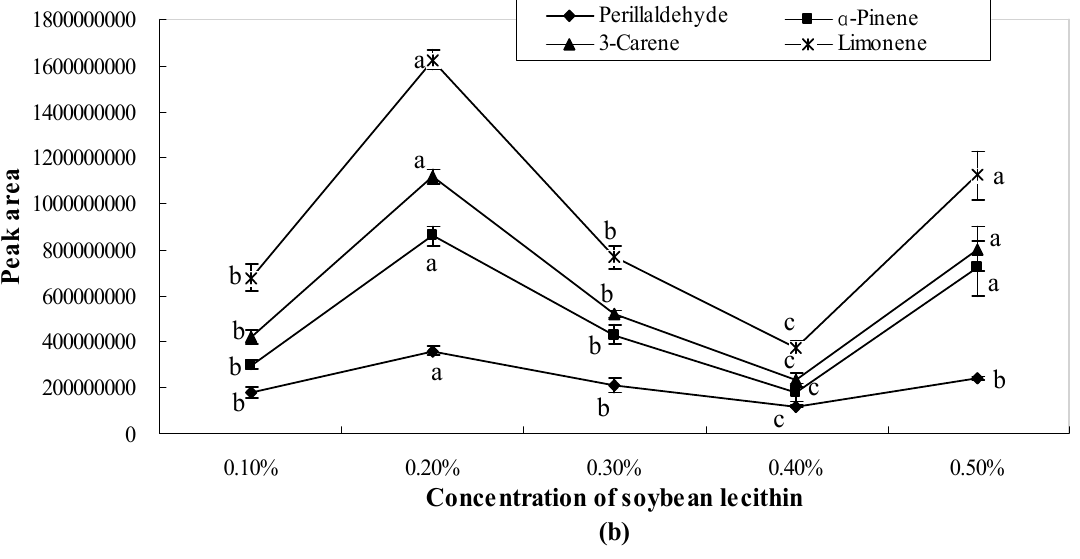
Figure 2. Effects of soybean lecithin on the release of ethyl acetate, ( E )-2-hexenal, carvone ( a ) and perillaldehyde, α -pinene, 3-carene, limonene ( b ). Significant differences ( p < 0.05) between different concentrations are performed by letters on the same polylines. Where the letters on the same polyline are the same, there is no significant difference between different concentrations.